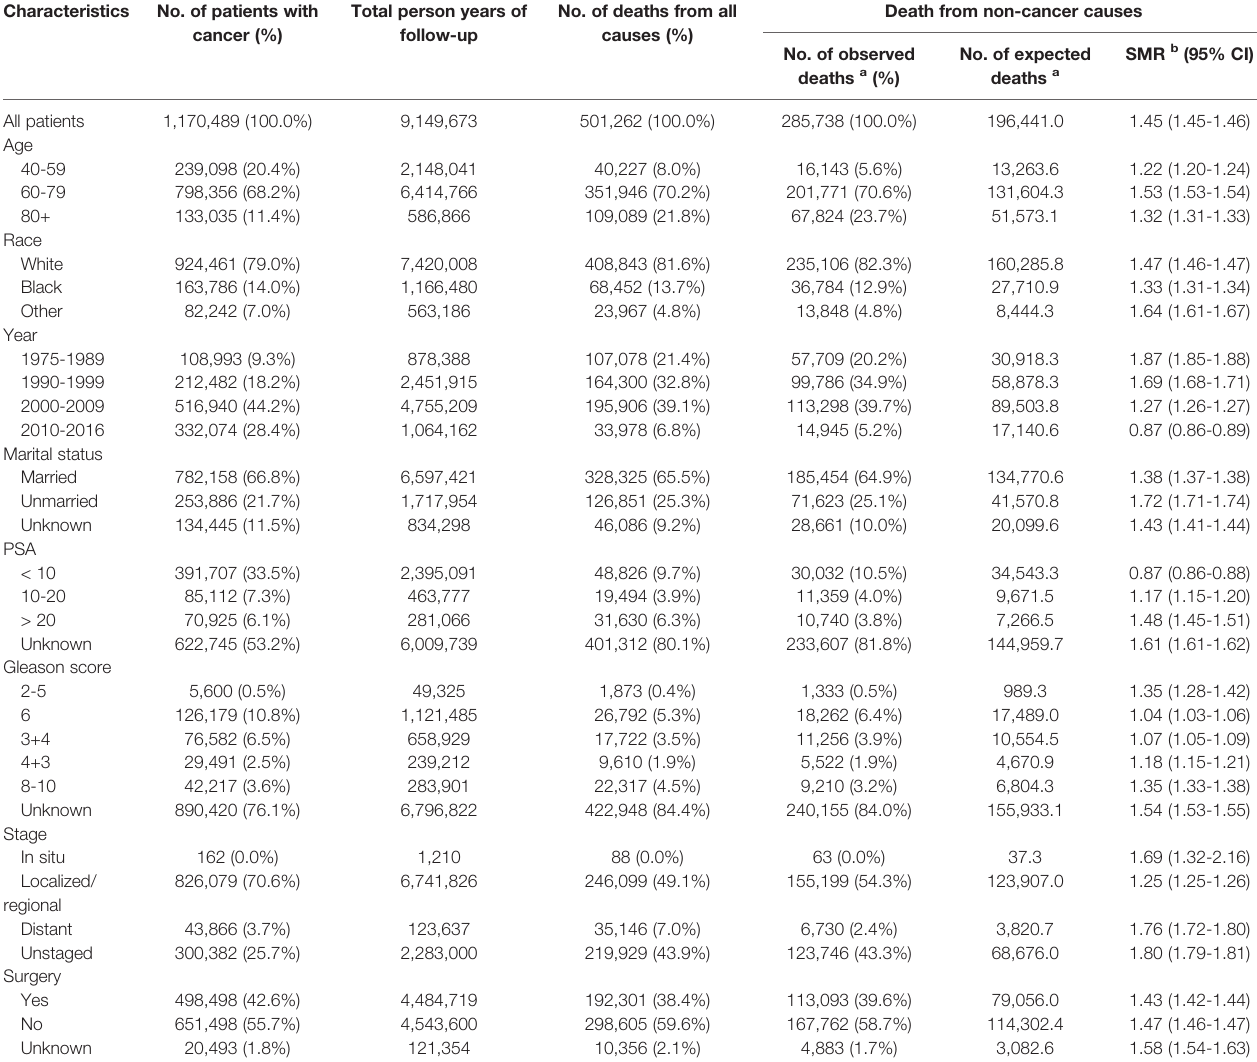
TABLE 1 | Baseline characteristics of patients diagnosed with prostate cancer between 1975 and 2016 in SEER 18 registries.